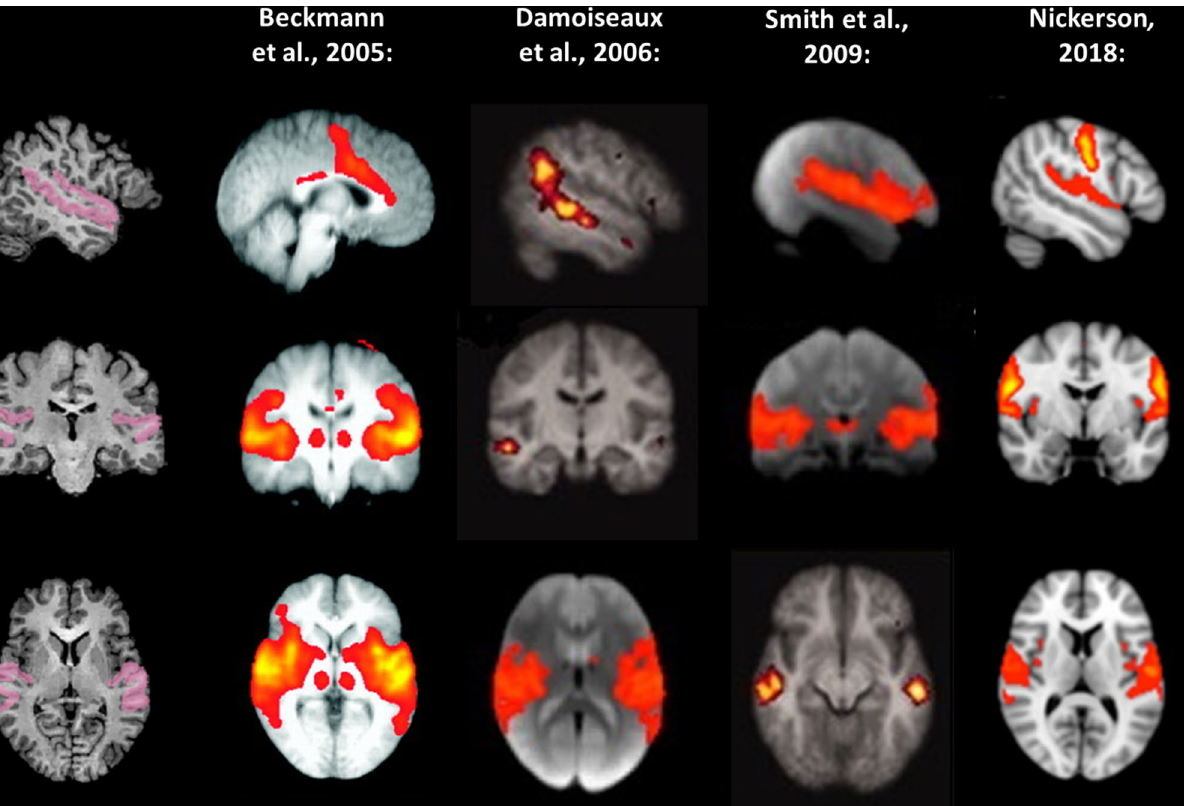
Figure 6. Left and right auditory seeds (pink) used in the present study. For comparison, the auditory system, as described in previous studies, is likewise depicted. Images modified from Beckmann et al. 6 , Damoiseaux et al. 7 , Smith et al. 8 , and Nickerson 9 , and generated using Microsoft®